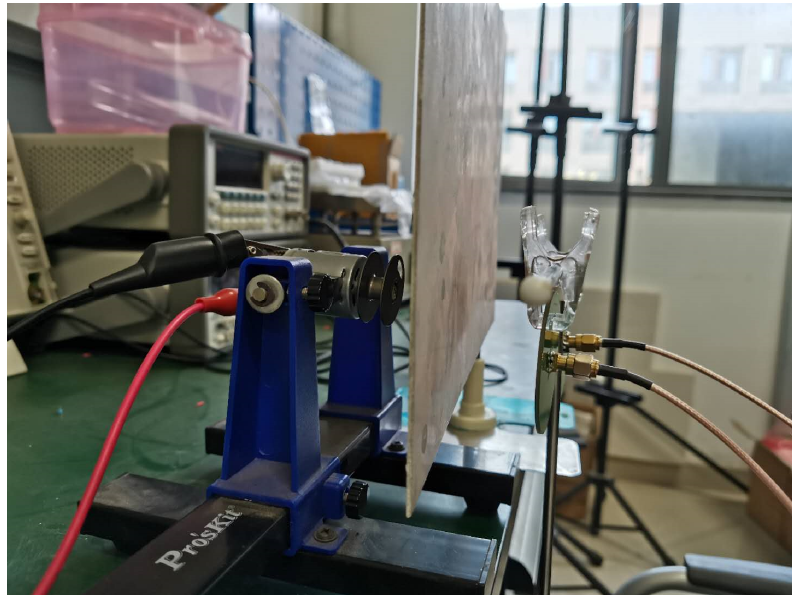
Figure 15. The experimental system with occlusion.